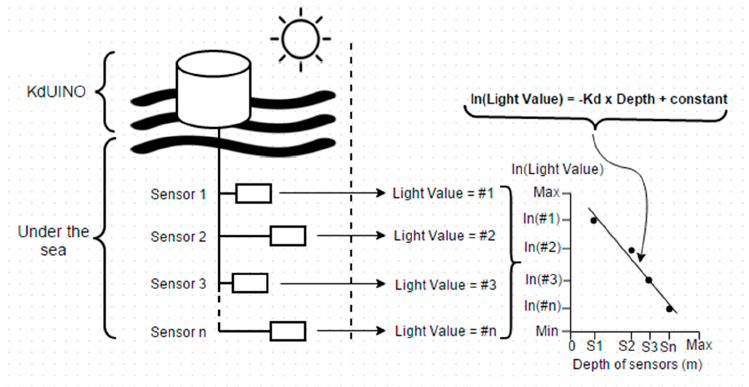
Figure 1. Overview of the KdUINO’s design and computation of K d as the slope of the linear regression of the measurements.